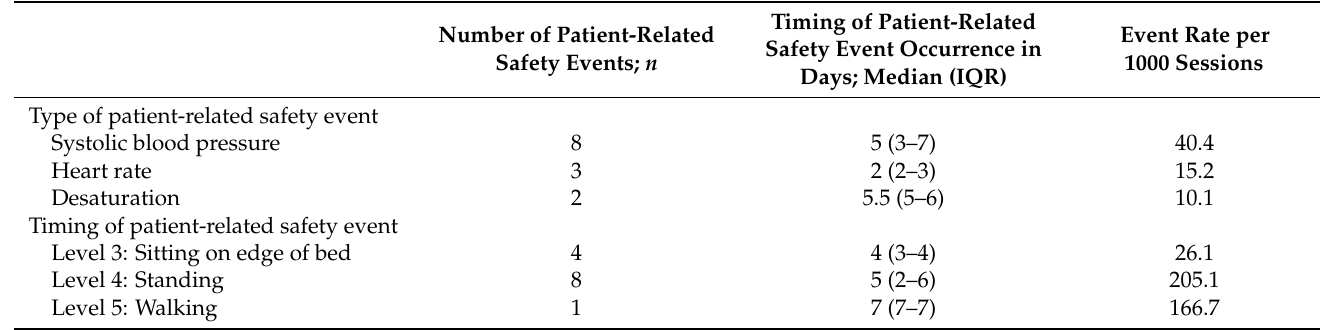
Table 3. Types and timing of patient-related safety events.